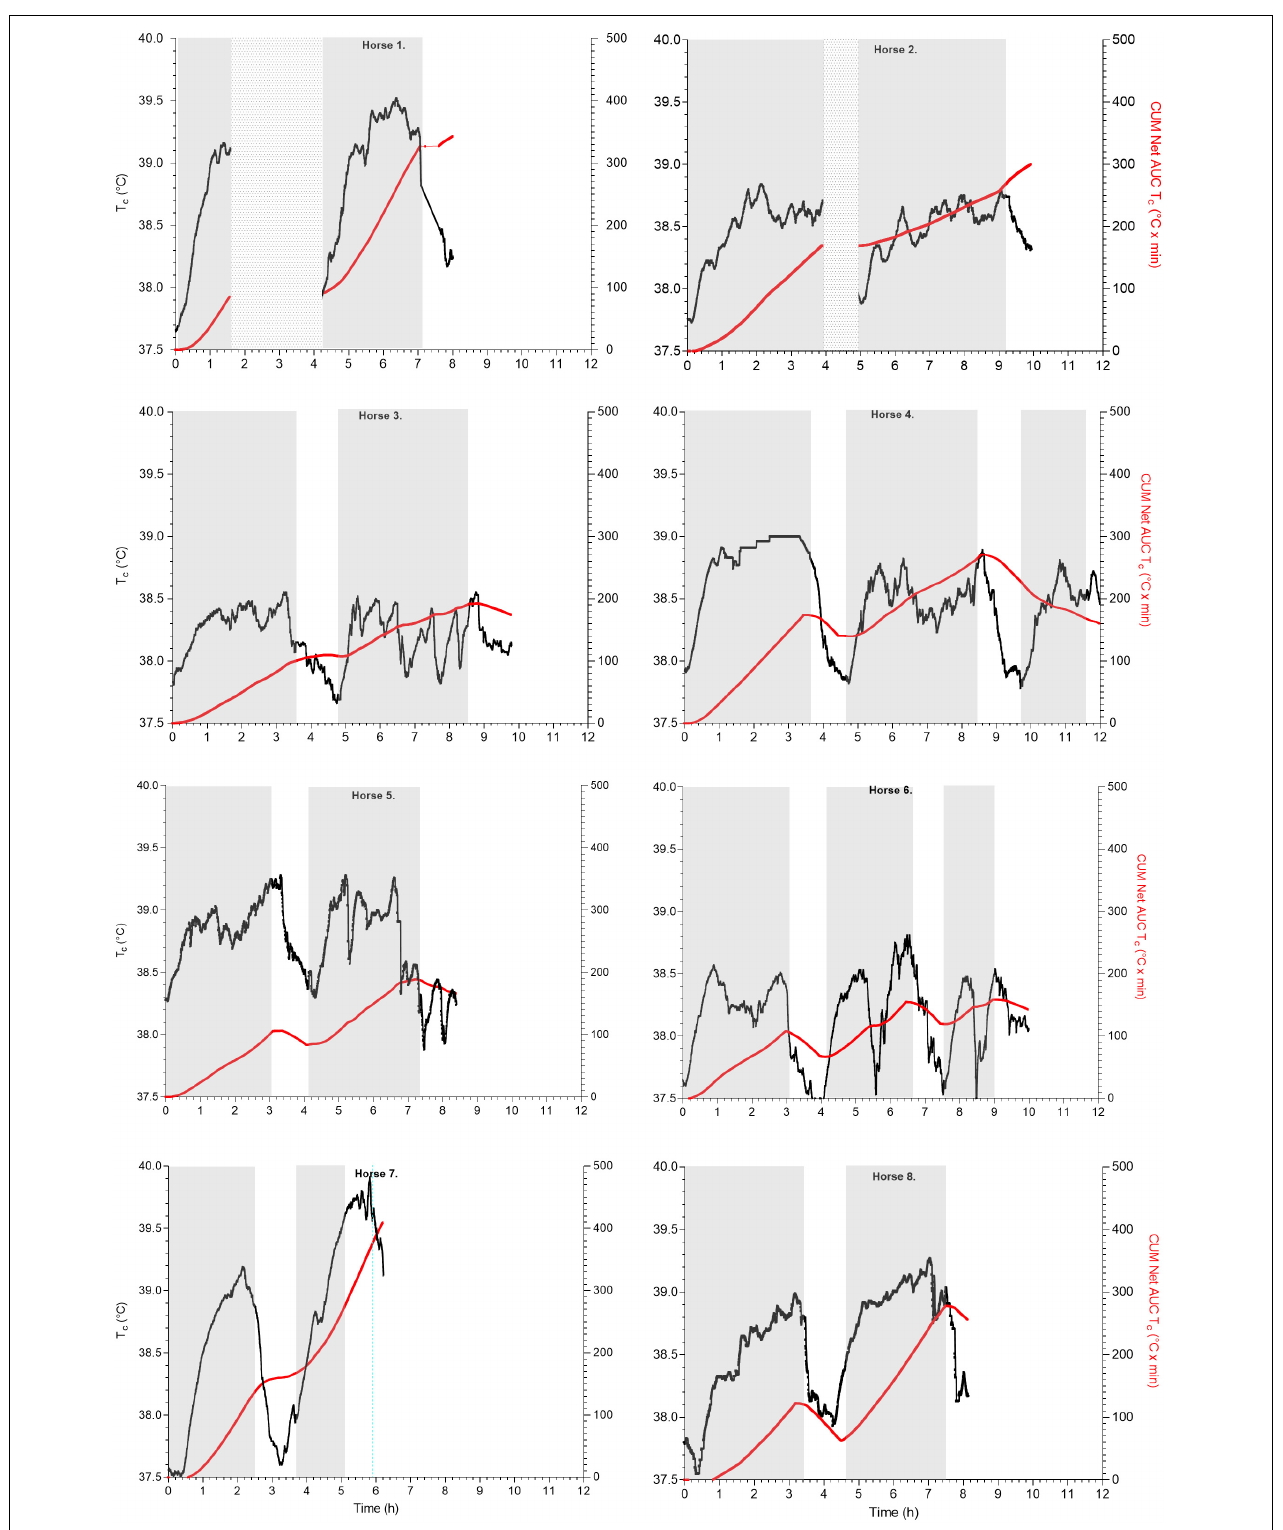
FIGURE 4 | Scatterplots of T c ( ◦ C; left y -axis, black line) and cumulated net AUC (T c ◦ C × min; right y -axis, red line) over time (hours, h) during T c exercise periods (identified as gray blocks) and recovery in endurance horses H1–8; H1 data loss at end of leg 1 and H1, H2 without T c recording during the first recovery (identified as spotted blocks); H4, H6 continued to 100 km